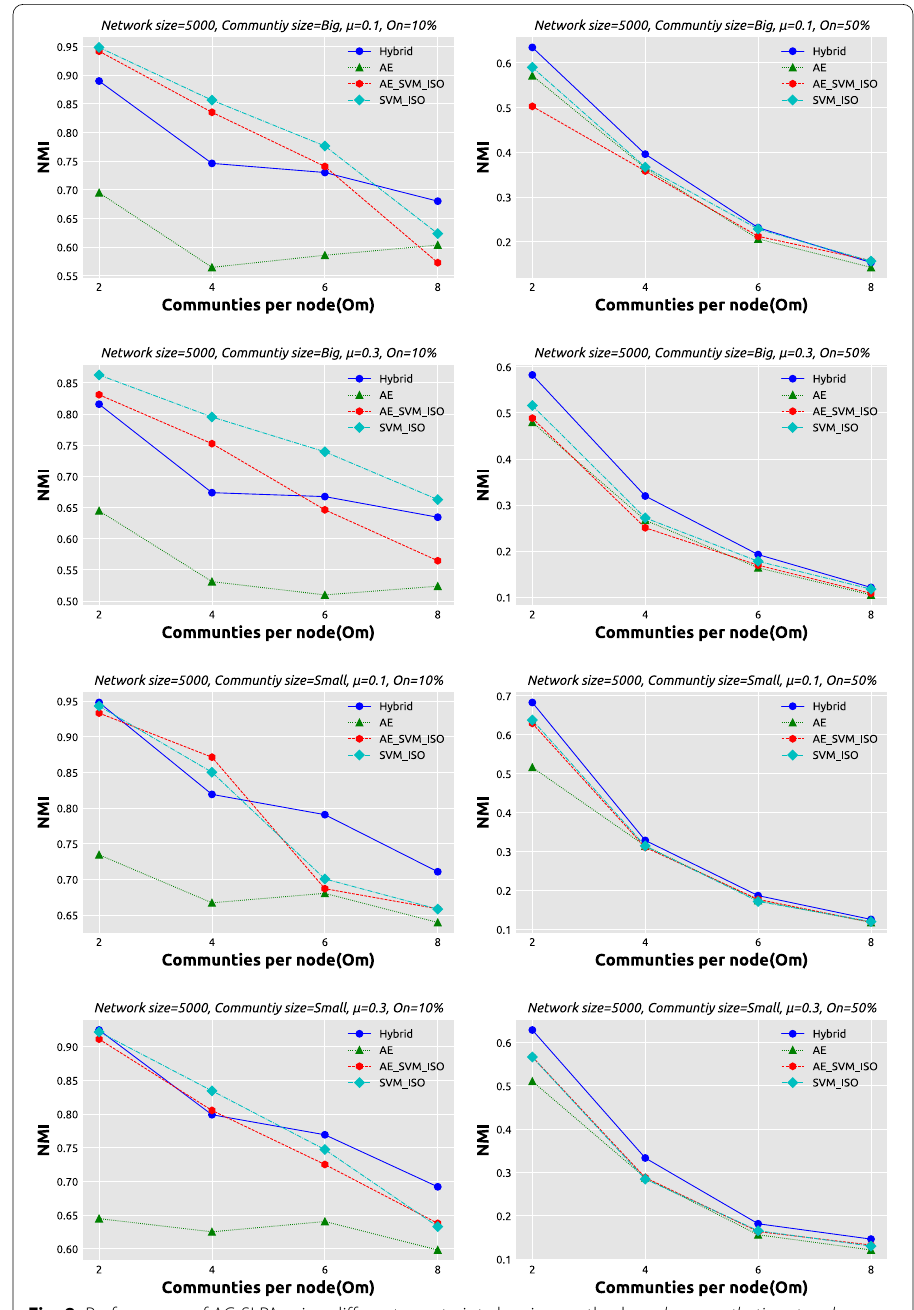
Fig. 8 Performance of AC-SLPA using different constraint cleaning methods on large synthetic networks , containing both small and large communities, where the mixing parameter µ varies from 0.1 to 0.3. NMI values are plotted against the number of communities per node ( O m